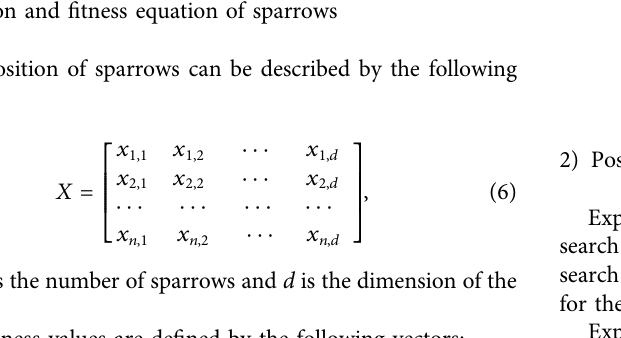
Frontiers in Energy Research |